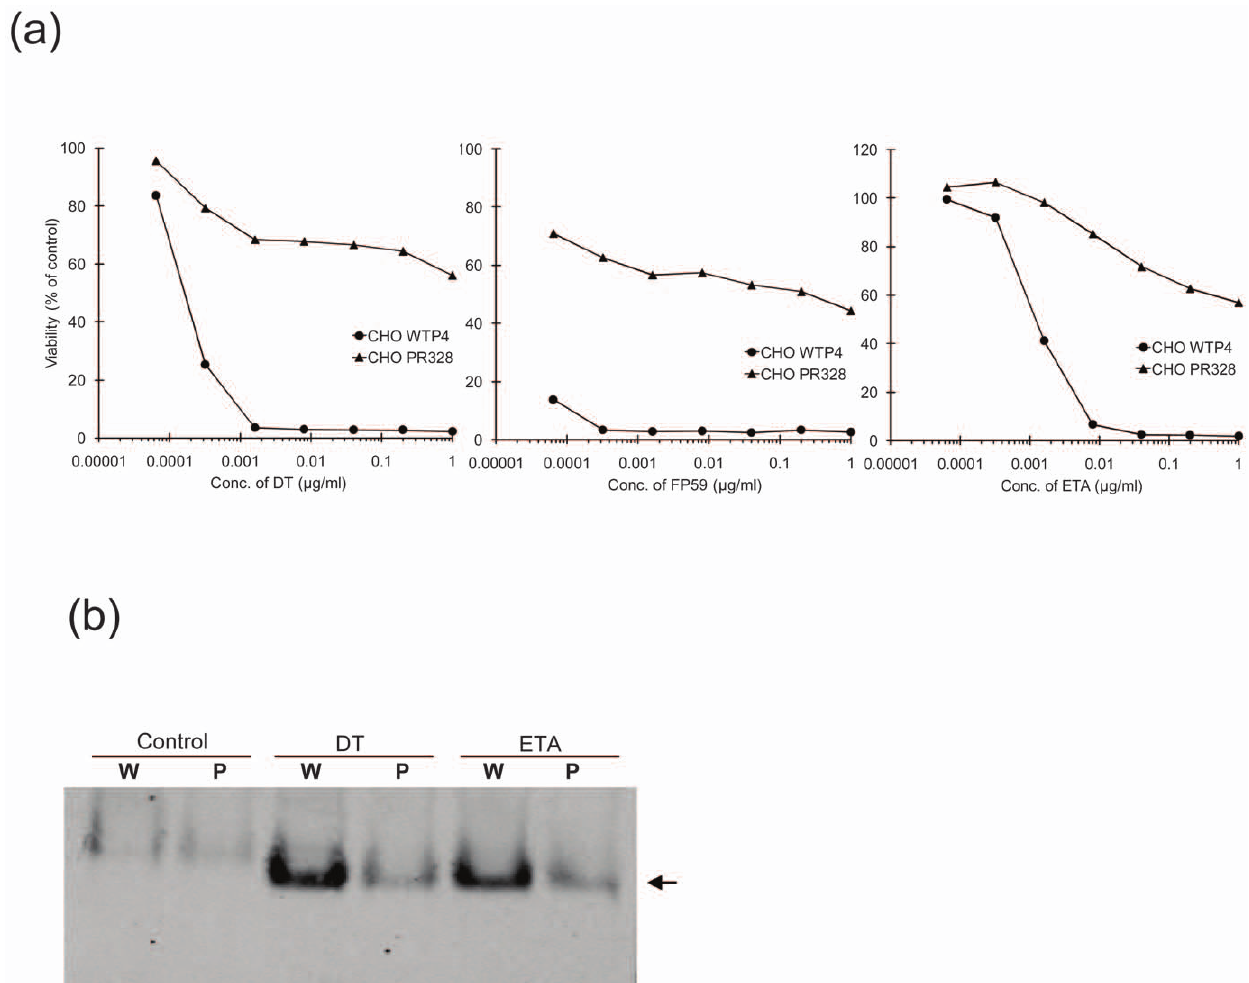
Figure 1. Toxin induced cytotoxicity and ADP-ribosylation of eEF-2. ( A ) CHO PR328 and their parental cells, CHO WTP4, were incubated with the indicated concentrations of toxins (in case of toxicity to FP59, PA was also added at a fixed concentration of 500 ng/ml). Cell viability was assessed at 48 h by the MTT assay. The A 540 values obtained for cells that received no toxin were considered as 100 % and used to calculate the percent viability of other data points. ( B ) Cells were treated with 100 ng/ml of diphtheria toxin (DT) or Pseudomonas exotoxin A (ETA) for 4 h and the cell lysate was tested for the presence of ADP-ribosylated eEF-2. Equal amount of cell lysate was subjected to native PAGE followed by western blotting with anti-eEF-2 antibodies. As discussed in ‘Results’, these antibodies react more strongly with the ADP-ribosylated form than with the unmodified EF-2. W and P symbolize CHO WTP4 and CHO PR328 cells respectively. Arrow indicates the ADP-ribosylated eEF-2.